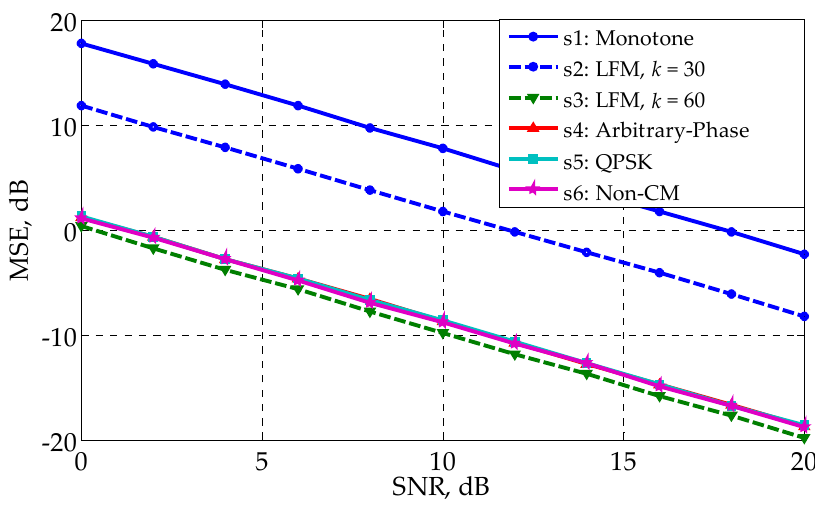
Figure 4. MSE (LS is used) versus SNR for different waveforms in the white noise.